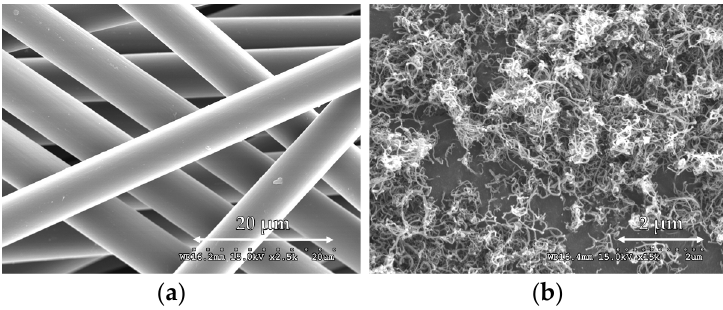
Figure 1. SEM images of CFs and MWCNTs; ( a ) CFs; and ( b ) MWCNTs. Table 3. Mix proportions used in this